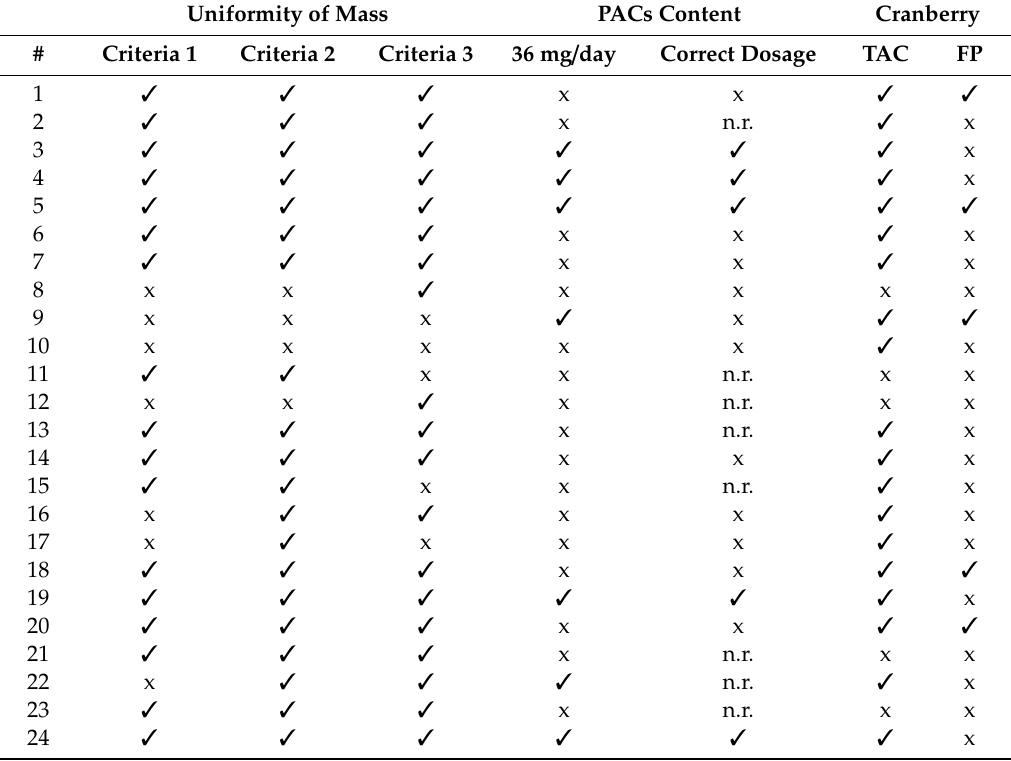
Table 4. Summary table of the quality control tests carried out on 24 Vaccinium macrocarpon -based dietary supplements. The symbol “ (cid:51) ” marks the passing of the relative test for each product. On the contrary, the symbol “x” marks when the DS failed to comply with the test. Criteria 1: FF complied with the test if not more than one individual mass was outside of the percentage established of the average mass (5% for tablets and 7.5% for capsules and sachets); Criteria 2: FF failed to comply with the test if one individual mass was outside of the double of these limits (10% for tablets and 15% for capsules and sachets); Criteria 3: FF failed to comply with the test if the ratio between the claimed mass and the average mass exceeded the 2%. The column “36 mg / day” reports if, following the suggested posology, the administration of at least 36 mg of PACs was guaranteed, while the adjacent column reports if the dosage claimed in the label was correct. The other columns respectively report the detection of anthocyanins (TAC), and whether the anthocyanin pattern was di ff erent from those of the V. macrocarpon fruits analysed in this experimentation (FP).